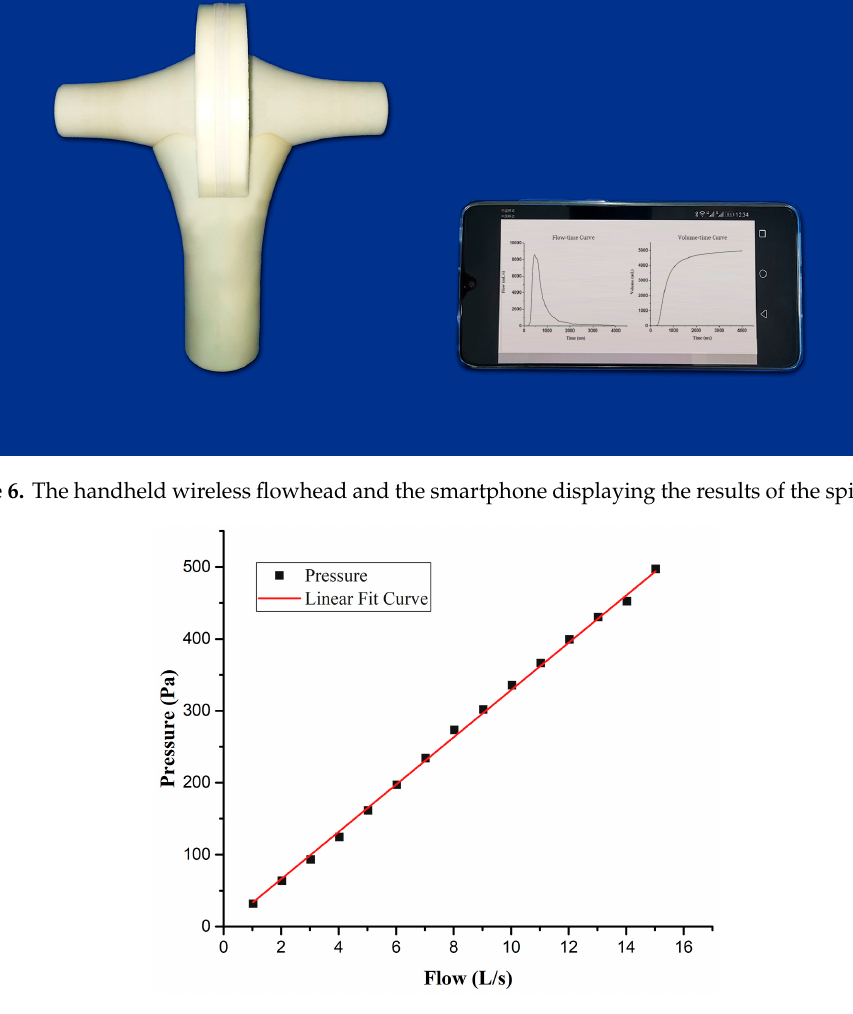
Figure 7. The resulting curve obtained from the test about the relation between flow rate and pressure difference of the handheld Lilly type sensing unit.